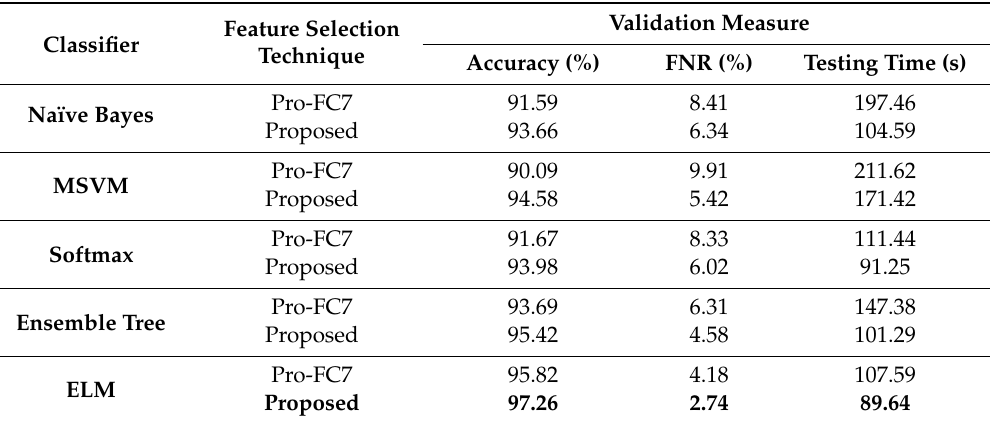
Table 4. Classification results for the BraTS 2017